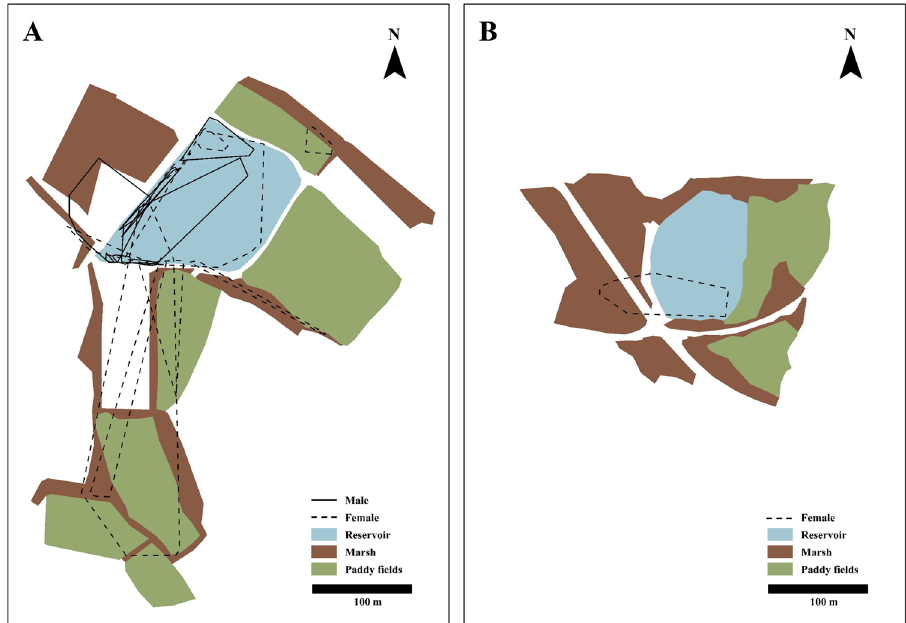
Figure 3. Home range of Lithobates catesbeianus in ( A ) Deokro and ( B ) Sango Reservoir in Hwangsan-dong, Gimje City, Jeollabuk Province, South Korea.